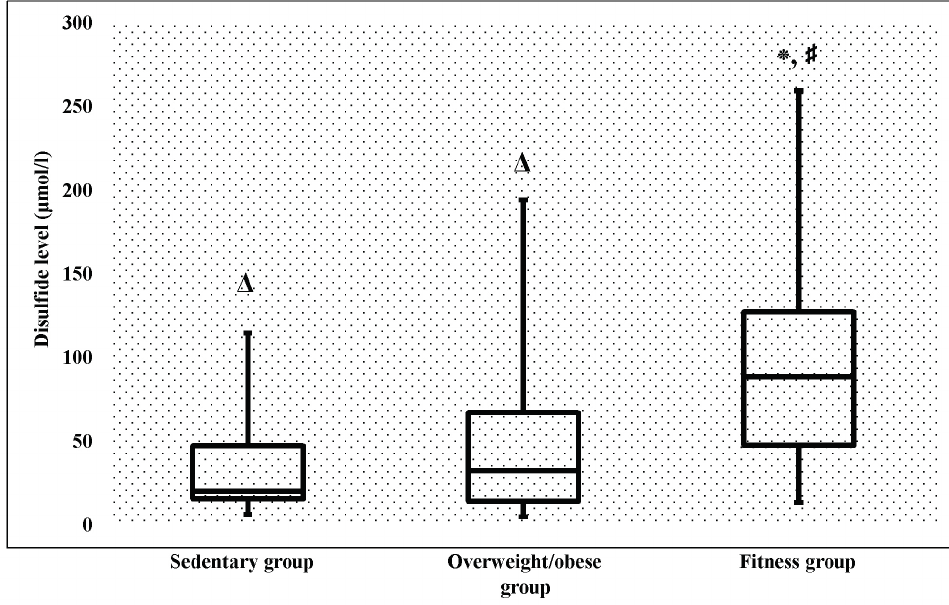
Figure 2 - Disulfide values of groups depicted by using boxplots. Disulfide values in fitness group are significantly higher than those in sedentary group and overweight/obese group (p<0.005, p<0.05). Independent samples Kruskal Wallis median test was used to compare descriptics of the groups. For pairwise comparison, Dunn’s test, which gives adjusted p values was